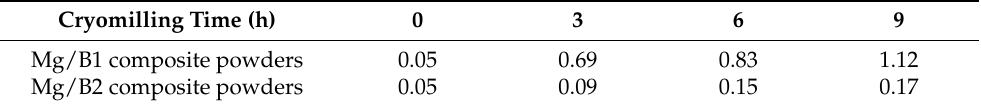
Table 6. The atomic ratio of Mg to B on the surface of Mg/B composite powders.